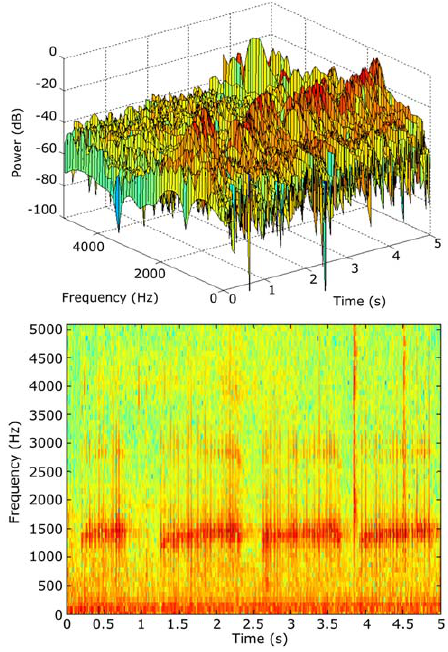
Figure 5. Audio spectrogram example.